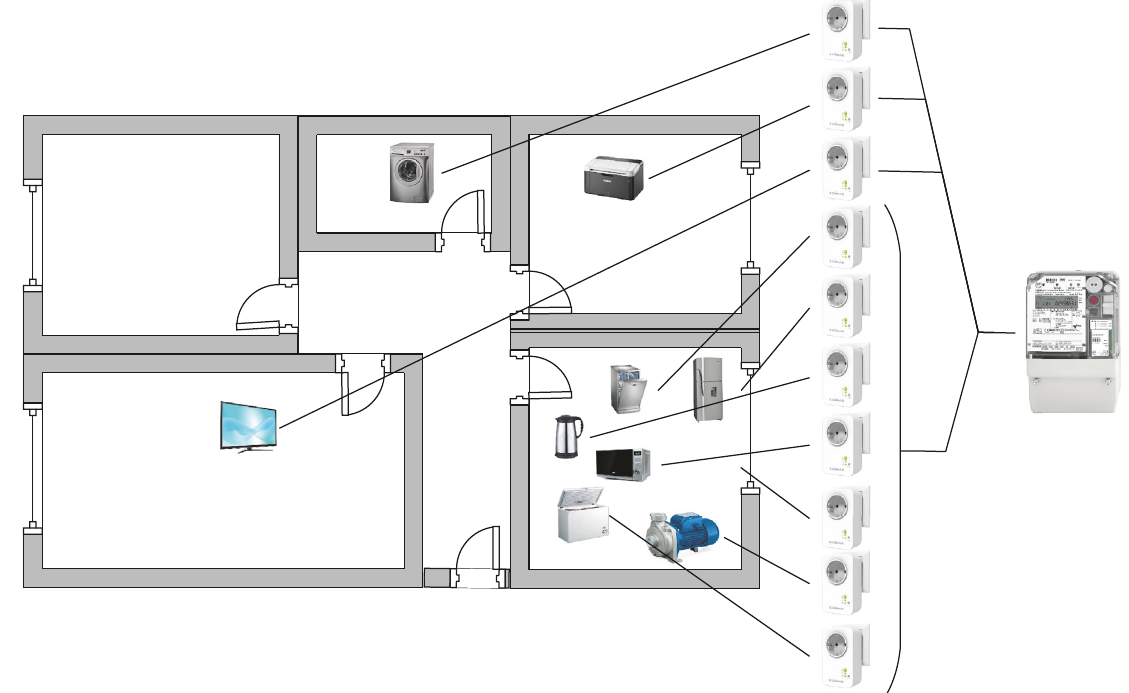
Figure 6: Distribution of the smart meter and smart plug in a house.